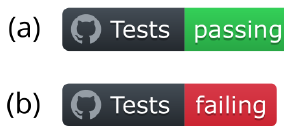
Figure 4. The status badge for the validation tests, which are pub- licly visible at PyCO2SYS’s GitHub repository (https://github.com/ mvdh7/PyCO2SYS#pyco2sys, last access: 23 December 2021), when the current version of the code (a) passes every test or (b) fails any test. Table 4. Results of an example round-robin test with PyCO2SYS with default parameterisation options. Other conditions: salinity